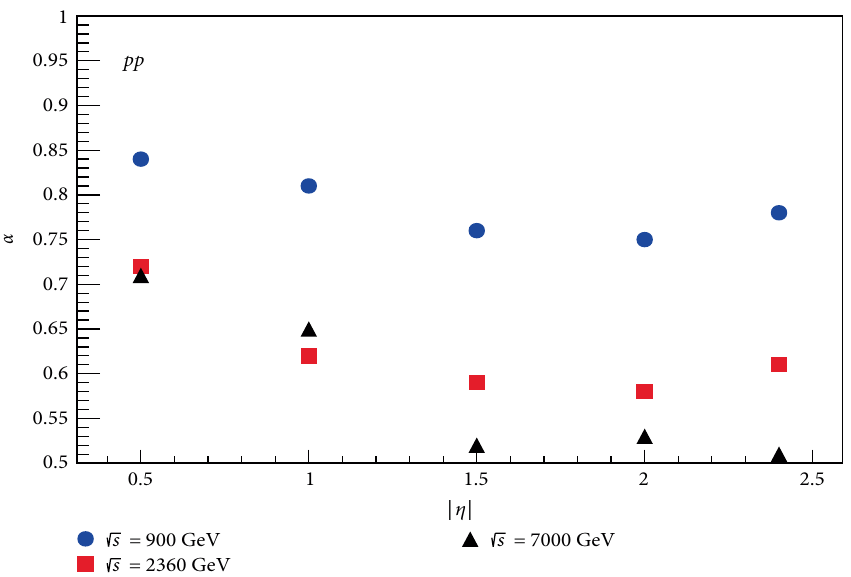
Figure 1: Dependence of on c.m. energy and pseudprapidity for pp 𝛼